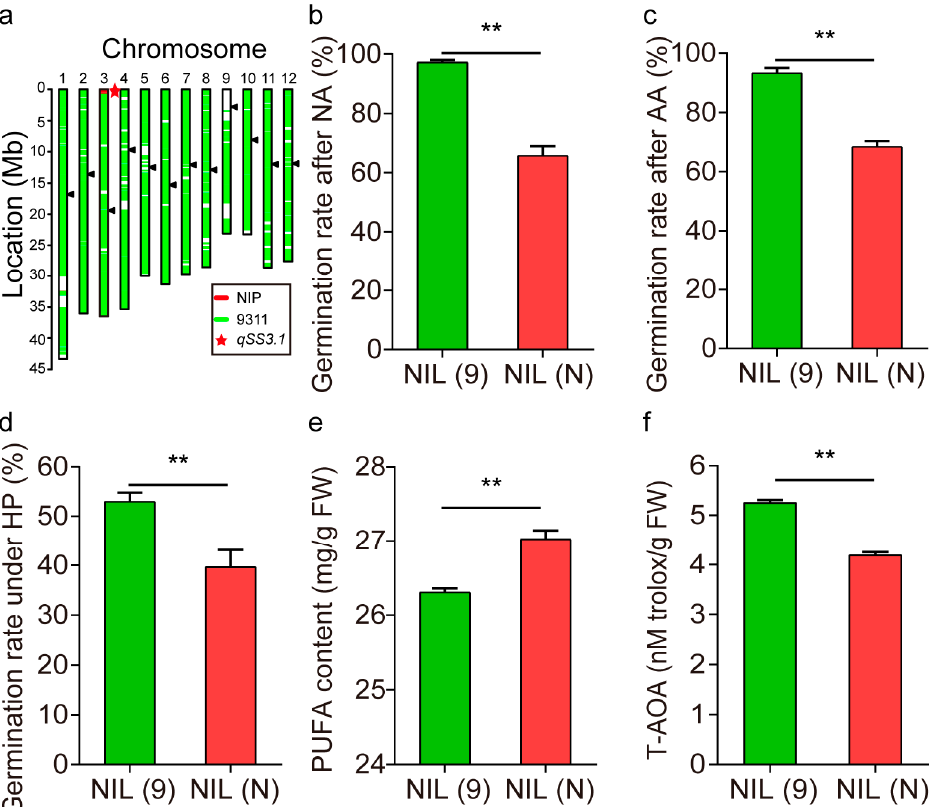
Figure 4. Comparison of the NILs that carry the contrasting alleles at qSS3.1 . NIL (9) harbors the 9311 alleles, while NIL (N) carries the NIP alleles. ( a ) Graphic genotype of NIL (N) showing the introduction of a small fragment (red bar) that contains qSS3.1 on the top of chromosome 3. Germination rate of the NILs after 6-m natural storage (NA) ( b ), artificial aging (AA) ( c ), and hydrogen peroxide (HP) ( d ). Polyunsaturated fatty acid (PUFA) content in the NILs ( e ), and total antioxidant activity (T-AOA) ( f ). Error bar represents mean ± SE with three replicates. Double asterisks denote significant di ff erence at p <